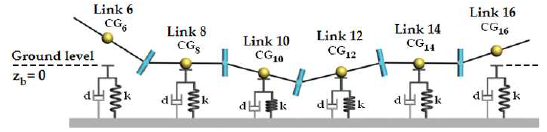
Figure 4: Modelling of contact forces between the snake and the